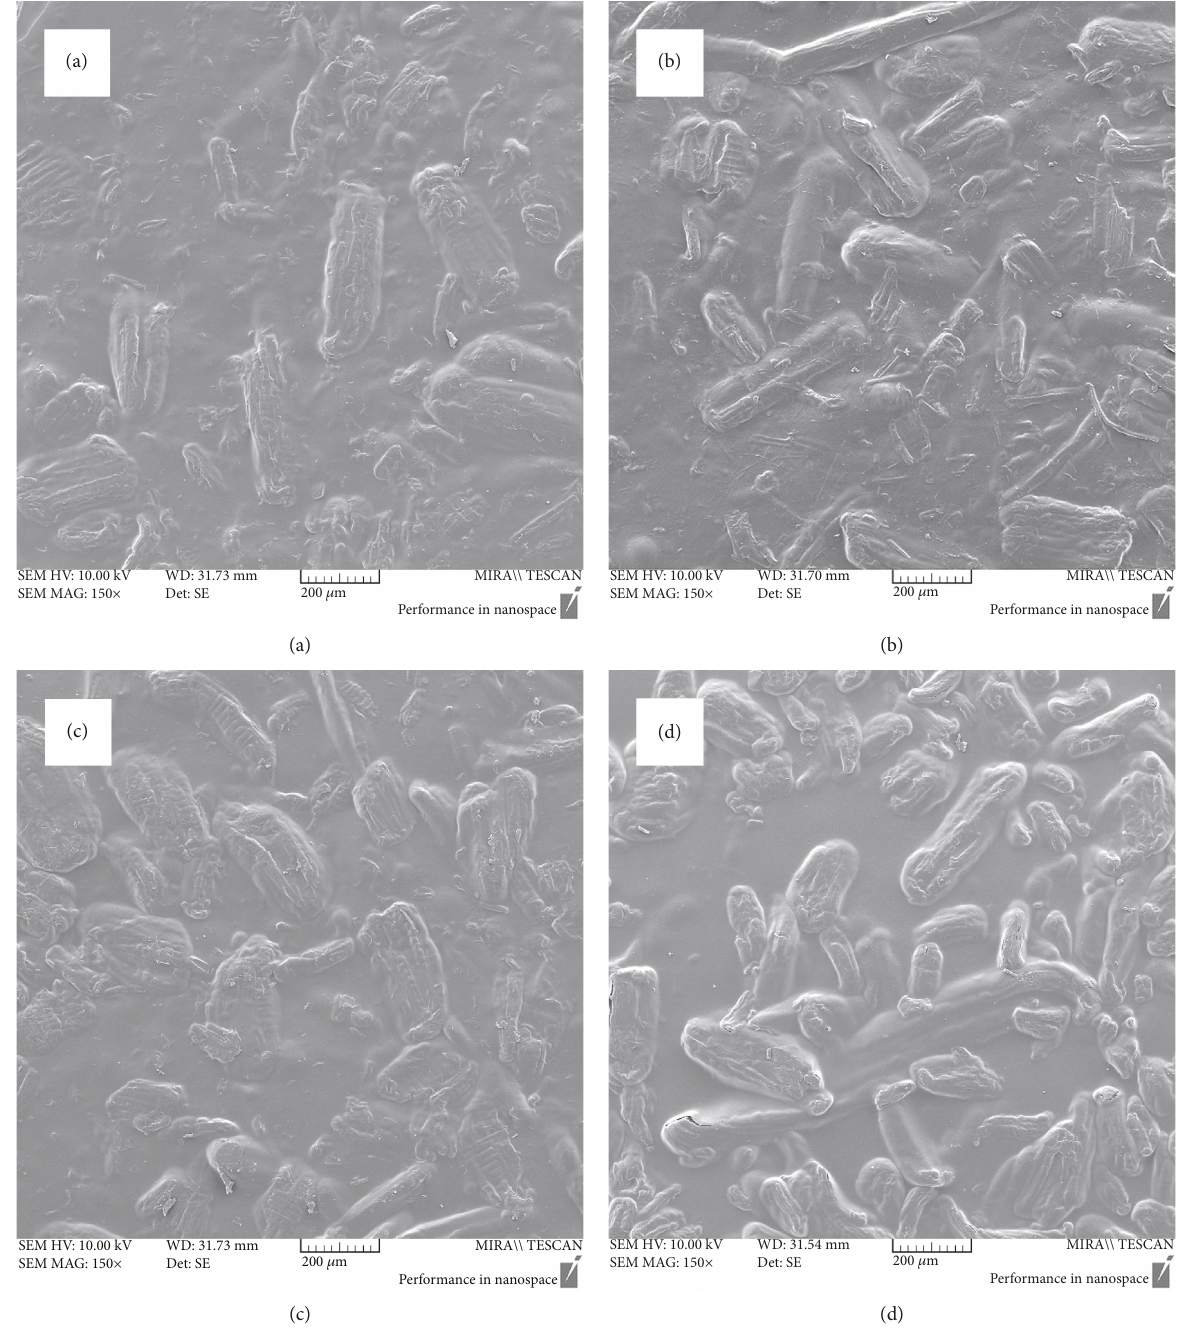
Figure 9: Surface morphologies of biocomposites prepared using holocellulose and alpha cellulose as fi